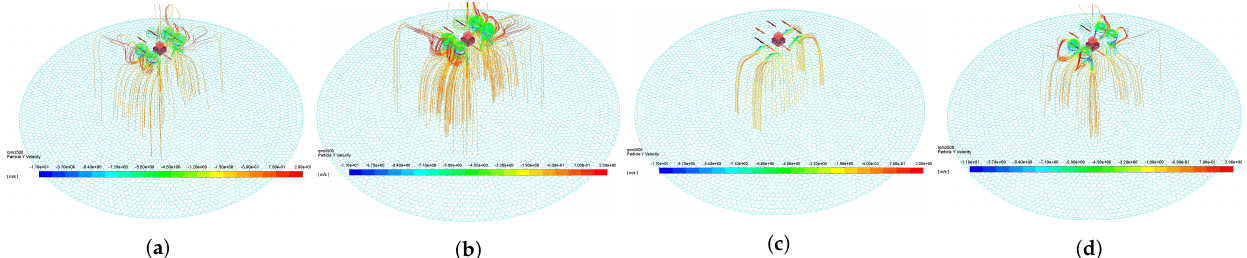
Figure 11. Droplet deposition trajectory under different nozzle states. The track color indicates the droplet velocity in Y − direction. ( a ) shows the nozzle working at a flow rate of 0.2 L/min, droplet diameter of 150 µ m, and a distance of 30 cm from the propeller. ( b ) shows the nozzle working at a flow rate of 0.5 L/min, droplet diameter of 150 µ m, and a distance of 30 cm from the propeller. ( c ) shows the nozzle working at a flow rate of 0.2 L/min, droplet diameter of 250 µ m, and a distance of 30 cm from the propeller. ( d ) shows the nozzle working at a flow rate of 0.2 L/min, droplet diameter of 150 µ m, and a distance of 40 cm from the